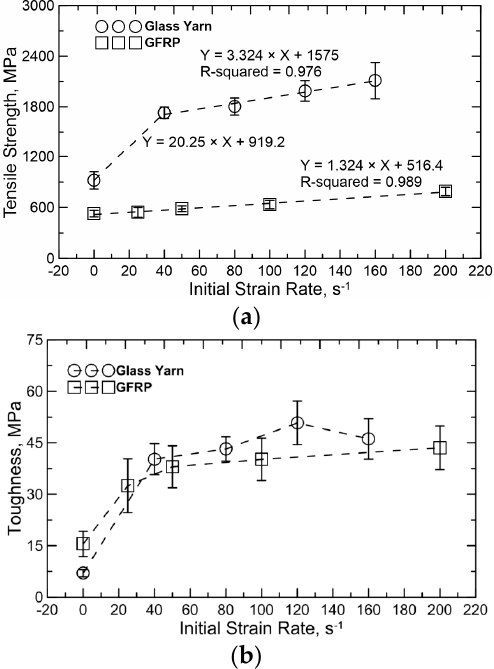
Figure 6. Strain rate effect on tensile properties: ( a ) tensile strength and ( b ) toughness.